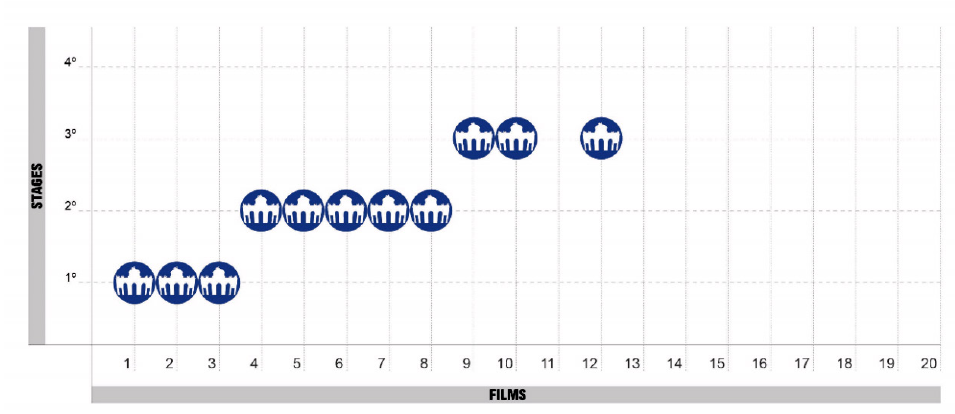
Figure 3. Locations indicator-Madrid: most representative films (source: created by